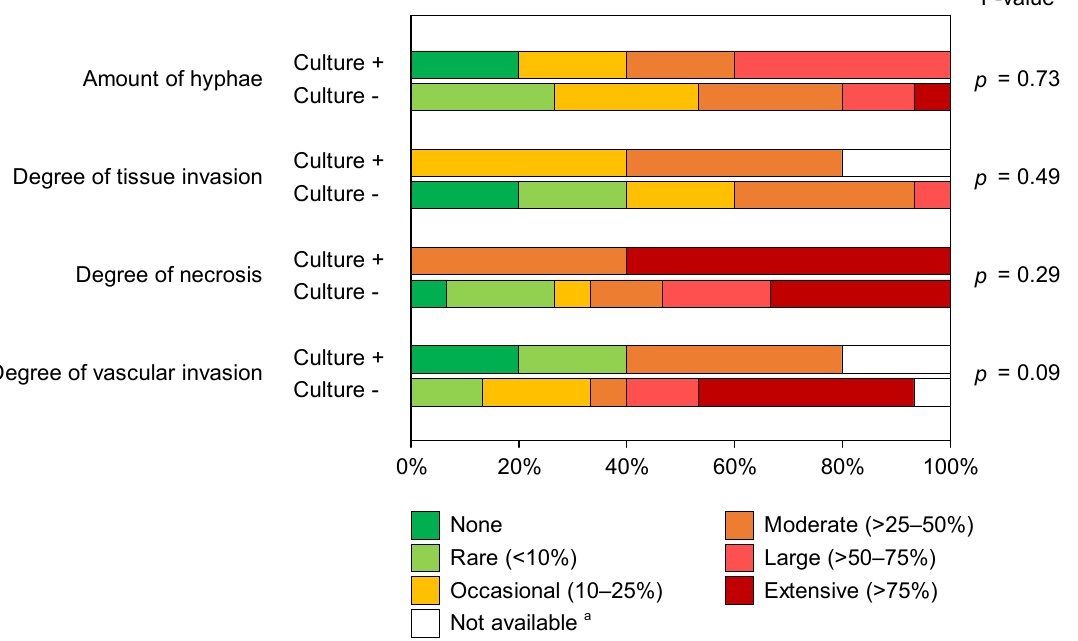
Figure 2. Stacked bar chart comparing the distributions of histopathological features of pulmonary mucormycosis in culture-positive and culture-negative patients. Mann–Whitney U test. a One case in the culture-positive cohort could not be evaluated on the degree of tissue invasion due to the lack of a corresponding GMS-stained slide. Additionally, two case specimens (one culture-positive and one culture-negative) did not contain vessels to evaluate vascular